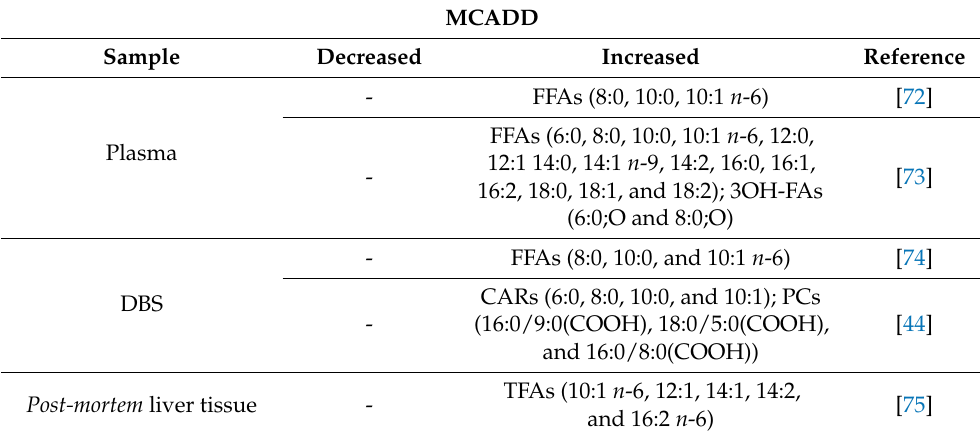
Table 2. Main lipid changes in plasma, post-mortem liver tissue, and dried blood spots (DBSs) of MCADD patients reported in published